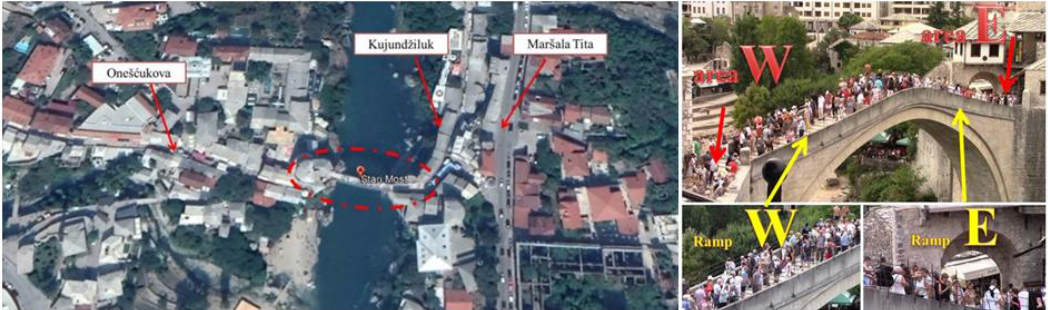
Figure 2. Images of Stari Most-Mostar in Bosnia-E. (Source: Google Earth).